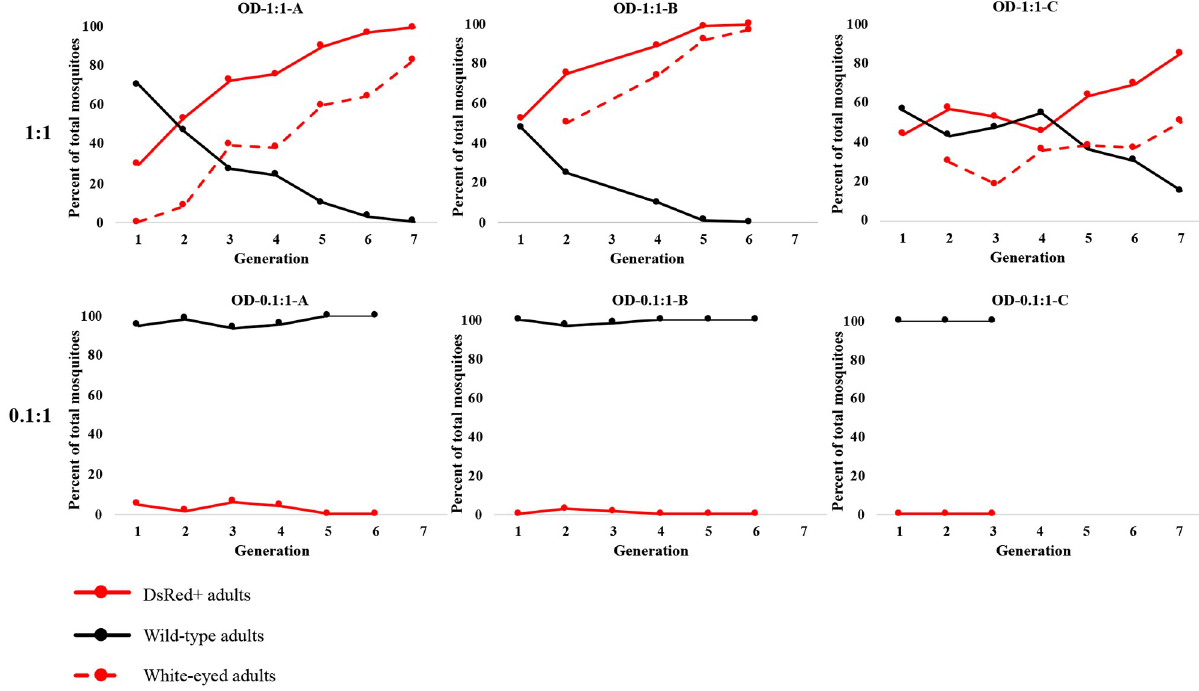
Fig 2. Adult phenotypes in an AsMCRkh2 overlapping gene drive (OD) cage trial. Two sets of triplicate cages (OD-1:1-A, -B and -C; OD-0.1:1-A, -B and -C) were set up with wild-type Anopheles stephensi pupae and the indicated ratios (1:1; 0.1:1) of AsMCRkh2 to wild-type male pupae. Larvae and resulting adults were screened in the first generation as DsRed-positive (DsRed + , carrying the AsMCRkh2 gene drive cassette; red circles and lines) or wild-type (no cassette; black circles and lines). The X-axis is the generation number following the start of the cages and the Y-axis is the percentage of total adults with the DsRed + or wild-type phenotype. The percentages of white eye and mosaic eye mosquitoes among the total also is shown (dotted and dashed red line).